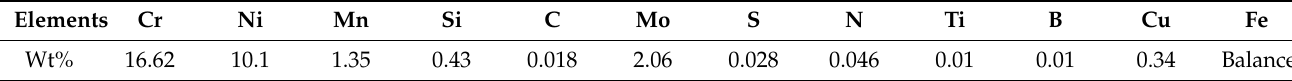
Table 1. Chemical composition of 316L stainless steel.